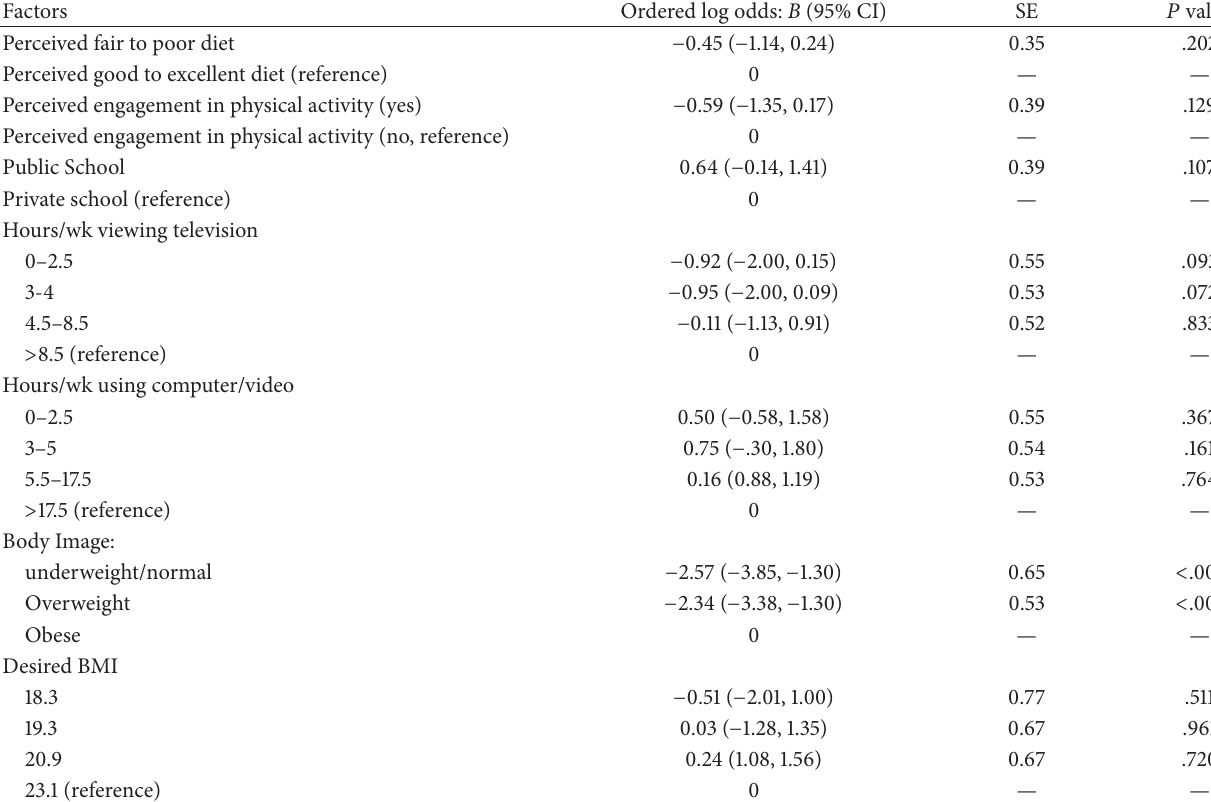
Table 4: Ordinal regression for BMI percentile categories (underweight/normal, overweight,